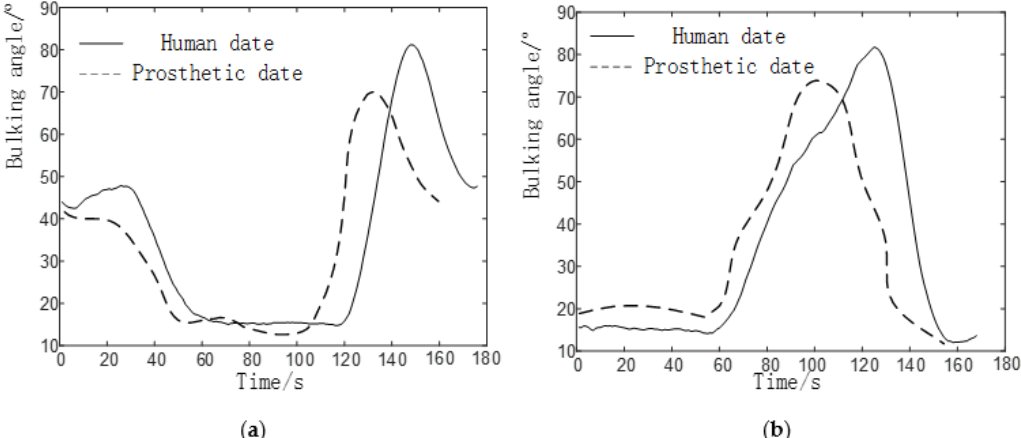
Figure 17. Comparison of knee prosthesis data and human data. ( a ) Knee joint angle change on the upstairs. ( b ) Knee joint angle change on the downstairs.